Question: Provide a one-line summary of what is displayed.
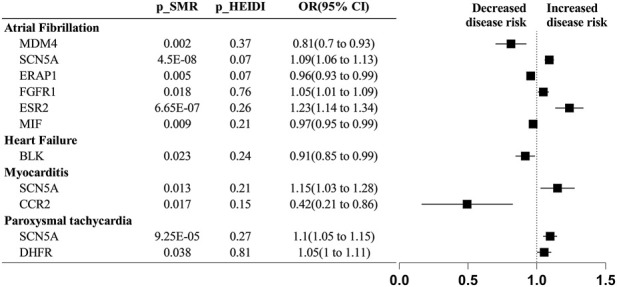
Answer: Forest plot for Mendelian randomization results for genes in relation to cardiovascular disease.